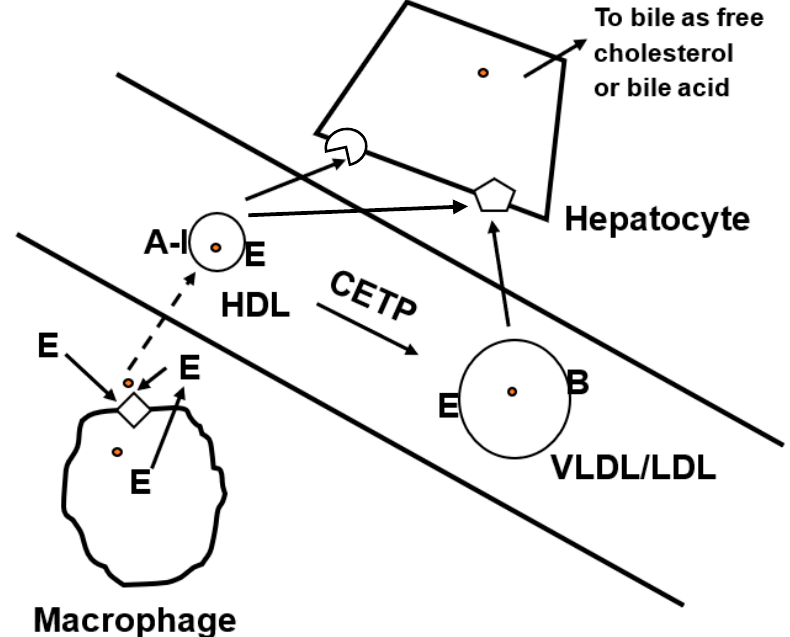
Figure 1. Apoprotein E (apoE) promotes cholesterol efflux and reverse cholesterol transport. Both exogenous and endogenous synthesized apoE can promote the efflux of cholesterol ( ) from cholesterol-loaded macrophages to form nascent discoidal high-density lipoprotein (HDL) after interaction with ABC transporters ( ). The nascent HDL with the effluxed cholesterol enters the plasma and via a number of steps (dashed line) is incorporated into mature spherical HDL particles. The HDL particles deliver the cholesterol to hepatocytes via interaction with scavenger receptor B1 (SR-BI) ( ) or low-density lipoprotein (LDL) receptor family members ( ). Alternatively, cholesteryl ester transfer protein (CETP) can mediate the transfer of cholesterol from HDL to VLDL and the effluxed cholesterol taken up by hepatocytes via the LDL receptor’s recognition of apoE or apoB.